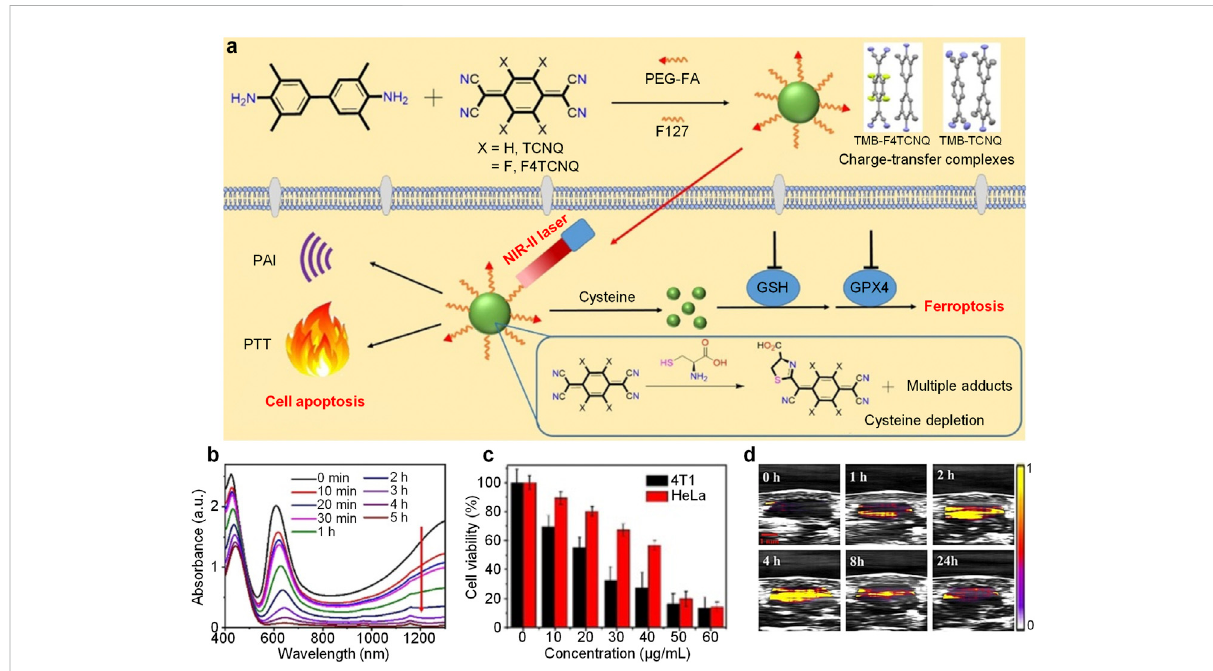
FIGURE 4 (A) Schematic illustration of preparation of charge-transfer complex nanoparticles and their applications in NIR-II PA imaging, PTT and ferroptosis. (B) AbsorptionspectrumchangeofTMB-F4TCNQundertreatmentofcysteinewithtimeat50 ° C. (C) Viabilityof4T1orHeLacellstreated with different concentrations of TMB-F4TCNQ under 1,060 nm laser irradiation. (D) NIR-II PA images of tumor region from TMB-F4TCNQ-treated 4T1 tumor-bearing mice at different post-injection time. The error bars represent standard deviations of three separate measurements ( n = 3). Adapted from (Ou et al., 2021). Copyright © 2021 Wiley-VCH